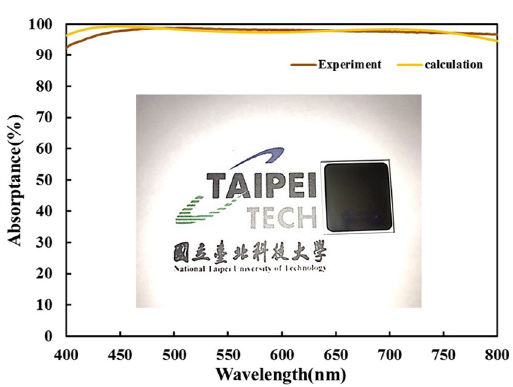
8 Scientific RepoRts | 7: 3076 | DOI:10.1038/s41598-017-03392-7